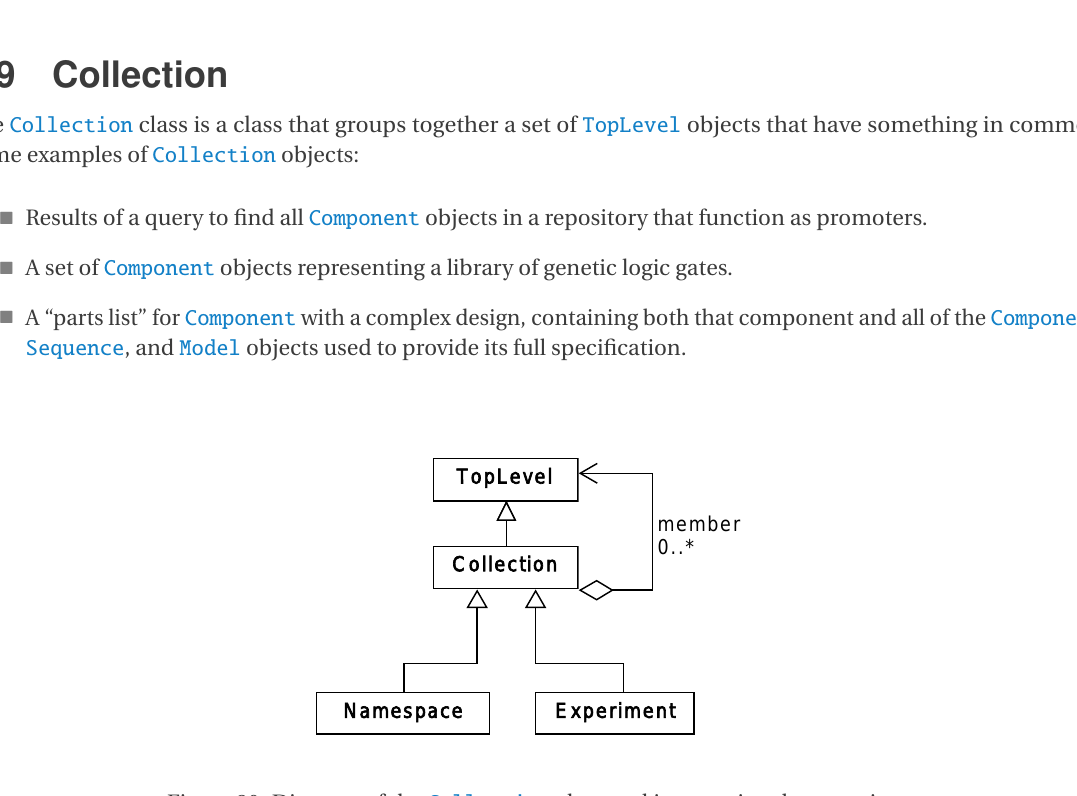
Figure 20: Diagram of the Collection class and its associated